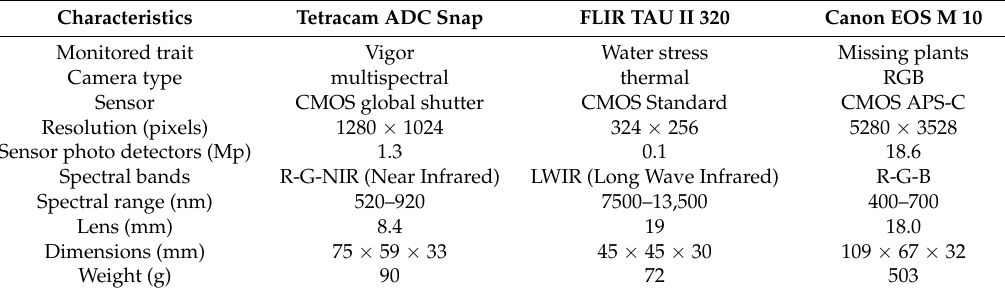
Table 2. UAV (unmanned aerial vehicle) camera specifications used in the three field Table 2. UAV ( unmanned aerial vehicle) camera specifications used in the three field campaigns.